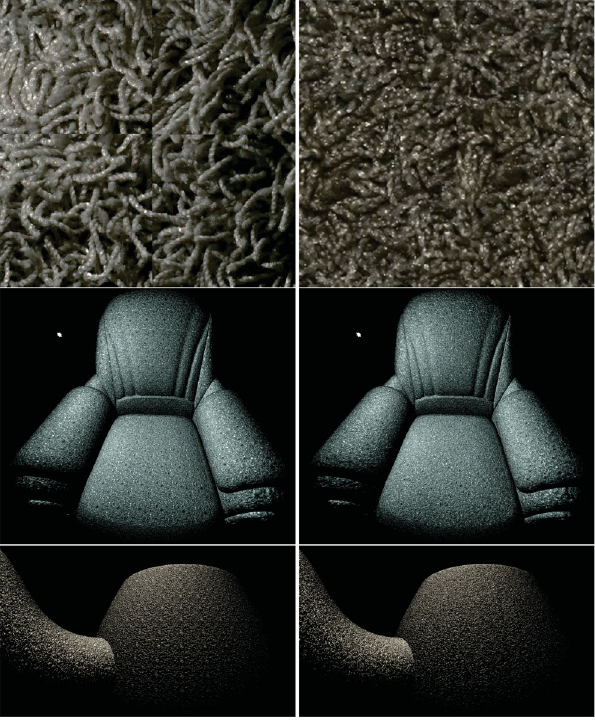
3D rendering of the ABTF material model. Left: state of the art before this work. Right: our results. Above: plane mapped with 2 × 2-tiled texture, showing clear discontinuity boundaries at the seams, that are entirely removed by our solution. Center: armchair model mapped with multi-repetition stone texture. Our results do not show any repetition artifacts. Below: teapot model mapped with carpet texture, exposing repetitions of identical textures, while our result seems to consist of one non-repetitive texture